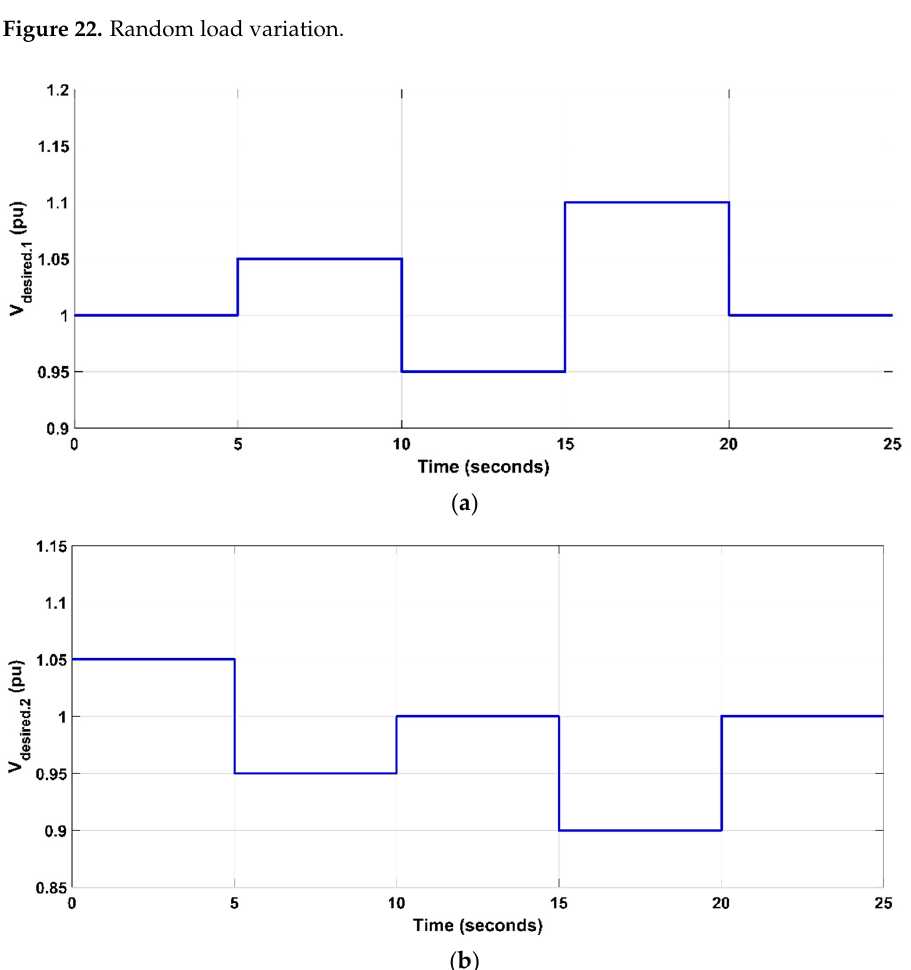
Figure 23. The time-varying desired voltage ( a ) in area 1 and ( b ) in area 2.